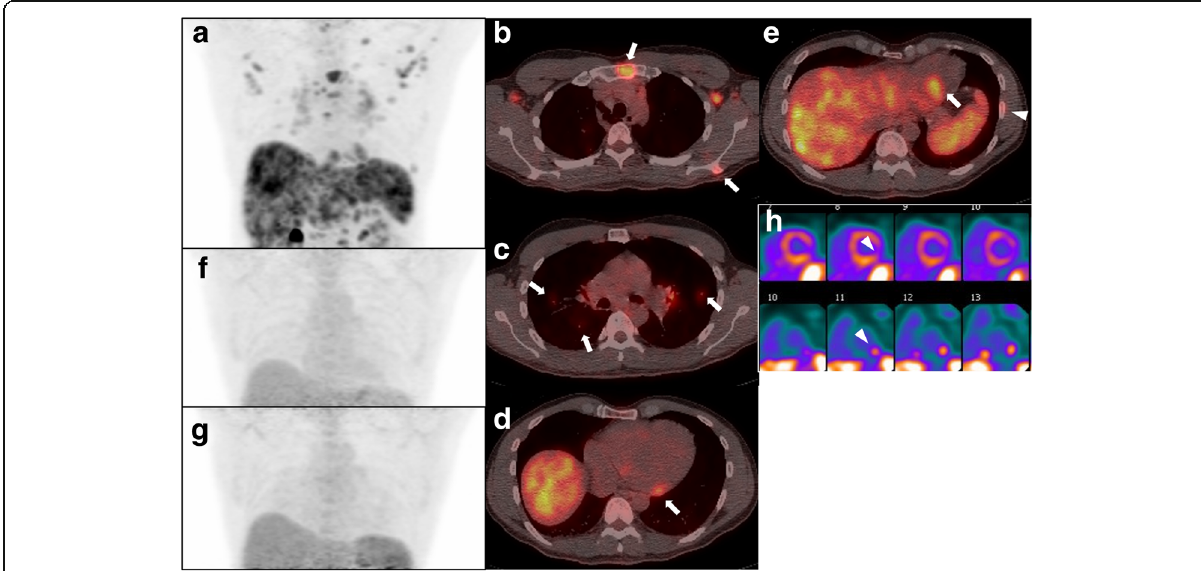
Fig. 2 Representative case from the group with daily maintenance dose of prednisone of ≤ 10 mg (patient no. 3). Pretreatment FDG PET/CT ( a 3D maximum intensity projection; b , c , d , e fused PET/CT) demonstrate multiple organ diseases involving lymph nodes (thoracic and abdominal), the lung ( c , arrows), bones ( e arrowhead), heart ( d , e arrows), liver, and spleen. Reconstructed short axis images of the left ventricle ( h perfusion images on the top and FDG images on the bottom) show increased metabolic activity in the inferolateral wall with corresponding mildly reduced perfusion (arrowheads), suggestive of active inflammation. The max SUV, metabolic volume, and total lesion glycolysis of all involved organ system and the heart are 7.5 (liver), 1860.9 ml, and 6866.9 g, and 5.7, 84.1 ml, and 294.4 g, respectively. Follow-up PET/CTs performed at 3 months ( f ) and 9 months ( g ) since the initial study show complete metabolic resolution. The patient initially received 40 mg of corticosteroid daily, which reduced to 0 mg at 6